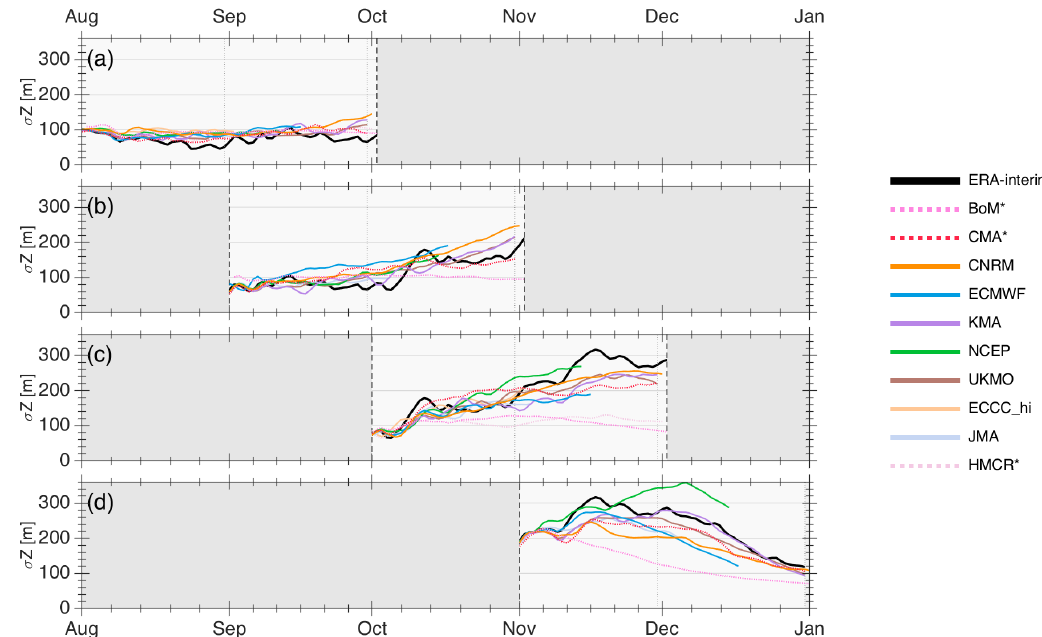
Figure 10. Interannual standard deviation of the Southern Hemisphere hindcast 50hPa polar cap (60–90 ◦ S) geopotential height for each model (colored lines) in comparison to ERA-I (black lines). The hindcasts closest to the first of each month are chosen for each model. The verification time range in each row spans a maximum of 8 weeks.